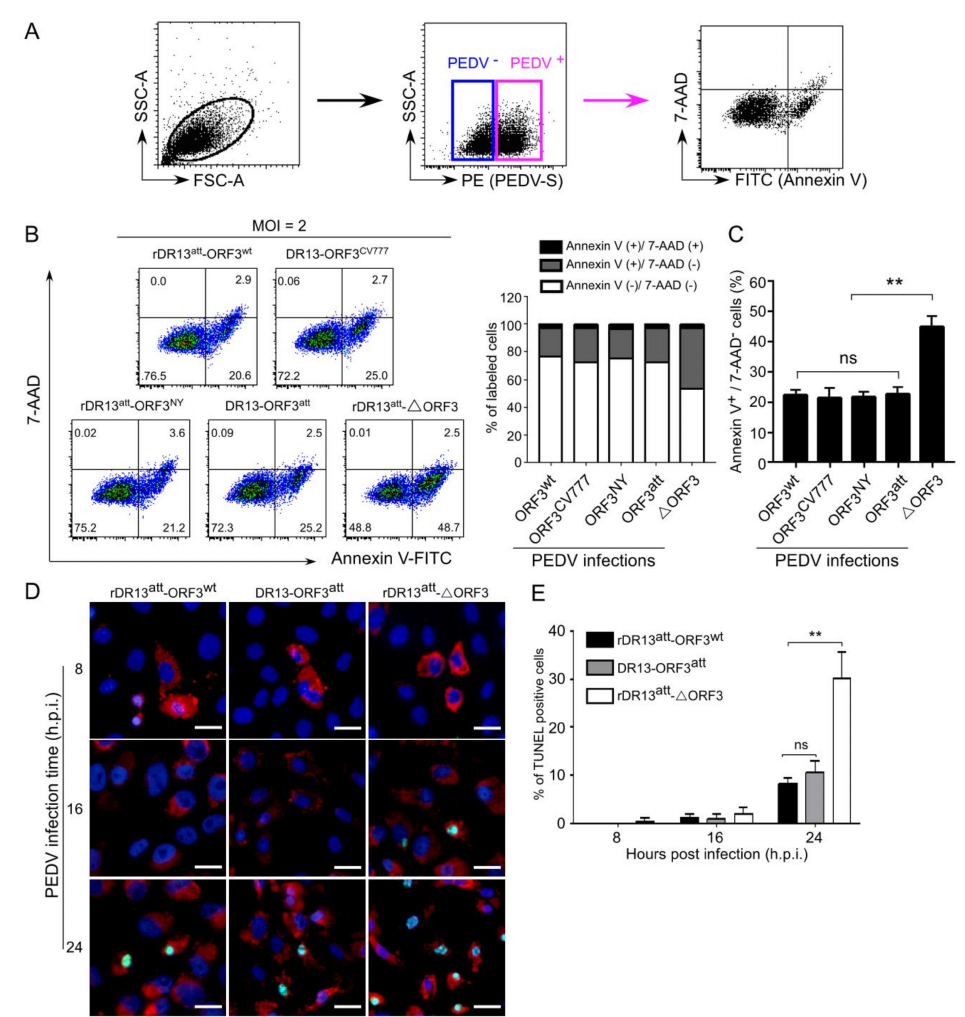
Figure 7. ORF3 has anti-apoptotic e ff ects on PEDV-infected cells. ( A ). Gating strategy to exclude PEDV negative cells before measuring the apoptotic parameters. ( B ). Flow cytometric quantitation of PEDV induced apoptosis. Vero cells cultured in 6-well plates were mock-infected or infected with the indicated viruses at an MOI of 2. At 24 h.p.i., cells were surface-stained using an antibody to the S protein under a non-permeabilized condition and subsequently dually labeled with Annexin V-FITC / 7AAD. The percentage of apoptotic cells was quantified in a population of PEDV S protein-positive cells by flow cytometry. The lower left quadrants represent live cells (Annexin V negative / 7AAD negative); the lower right quadrants represent early apoptotic cells (Annexin V positive / 7AAD negative); the upper right quadrants indicate late apoptotic cells (Annexin V positive / 7AAD positive); the upper left quadrants indicate necrotic cells (Annexin V negative / 7AAD positive). The figure is representative of three parallel tests. The right graph represents the percentage of cells in each quadrant infected with di ff erent viruses. ( C ). Graph summarizing early apoptosis in cells infected with the indicated viruses ( n ≥ 3; **, p < 0.01). ( D ). TUNEL staining of Vero cells after PEDV infection. Infected cells fixed at the indicated time post-infection were stained with an anti-PEDV-S antibody (red), labeled with the TUNEL reagent (green) and nuclei were counterstained with DAPI (blue). Staining was observed with a fluorescent microscope (Axio Scope A1, Carl Zeiss, Germany) and shown as merged pictures. Scale bar represents 50 µ m. ( E ). Quantification of TUNEL stained cells. The number of cells with TUNEL positive signals among PEDV infected cells was quantified by counting at least five fields per slide. Results shown in the histogram represent the mean ± SD from three parallel tests. Symbol ** indicates that the di ff erence between the apoptotic parameters of cells infected by rDR13 att - ∆ ORF3 and the other viruses is very significant ( p < 0.01); ns means: not